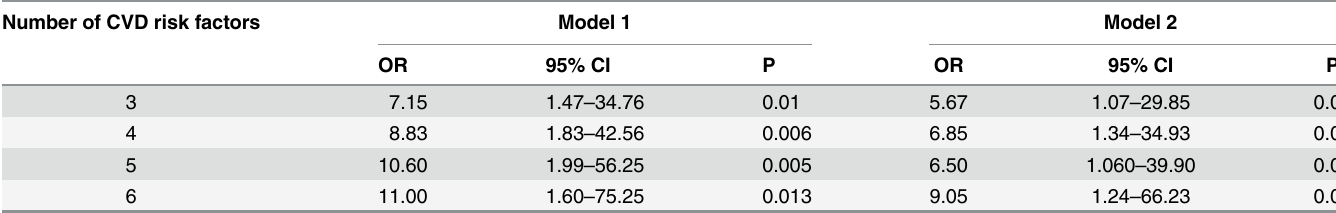
Data are expressed as ORs and corresponding 95% CIs.